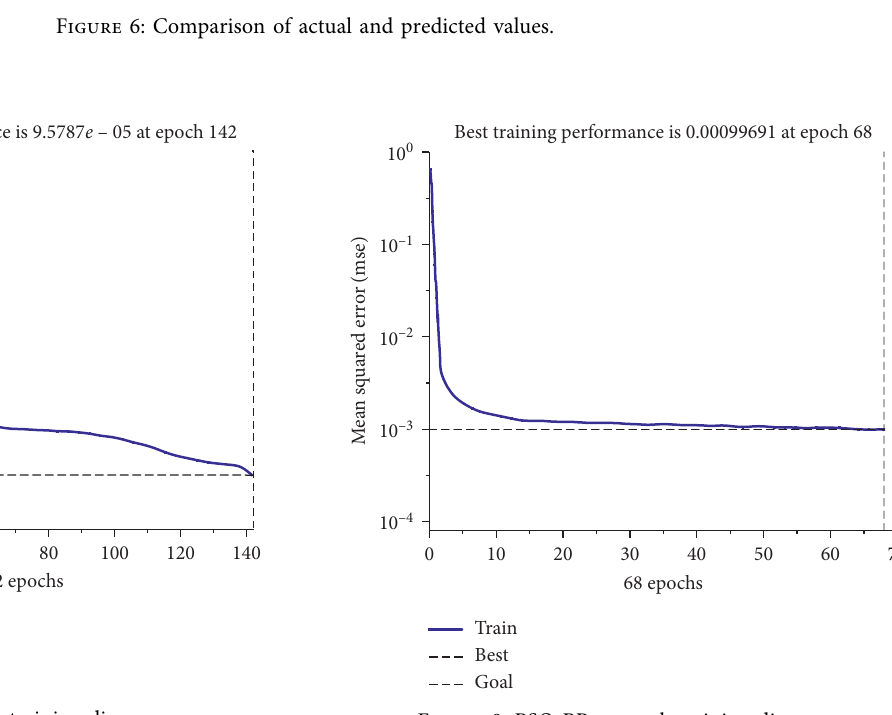
Figure 7: BP network training diagram. Figure 8: PSO-BP network training diagram.